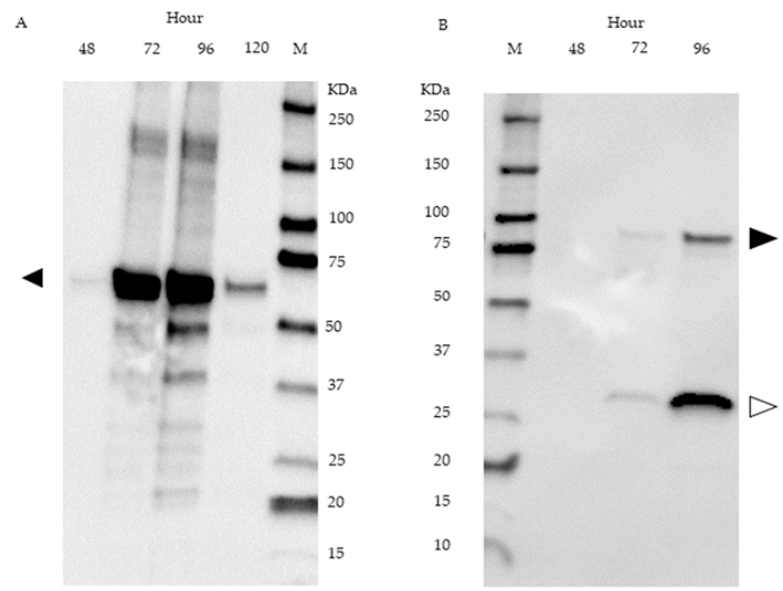
Figure 7. Western blot of supernatant samples from S. lividans cultures harboring SP Ka POxHis at 48, 72, 96 and 120 h ( A ) and SP Ka POxmRFPHis at 48, 72 and 96 h ( B ). A size marker is shown in lane M. The expected molecular weight of intact fusion protein and of the mRFP domain is 86.5 KDa (black arrow) and 26.6 KDa (white arrow), respectively.